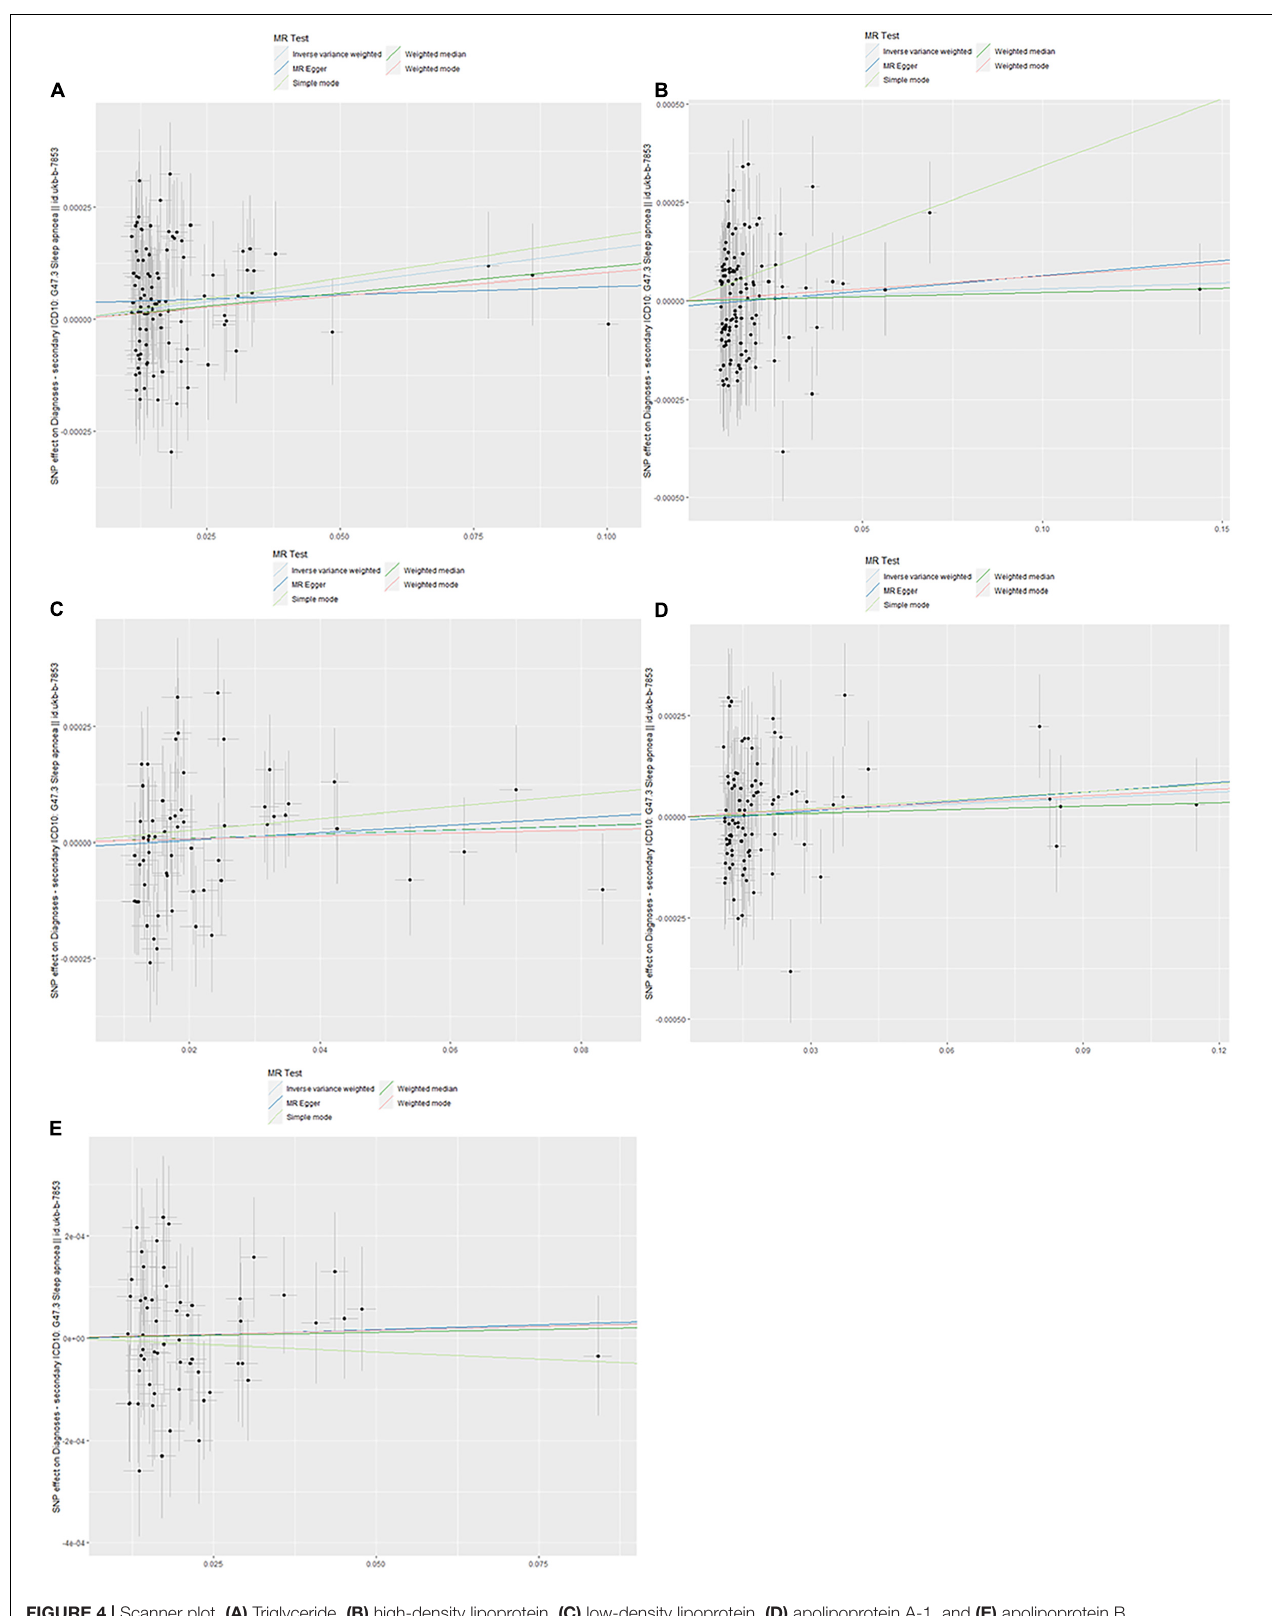
Frontiers in Nutrition |